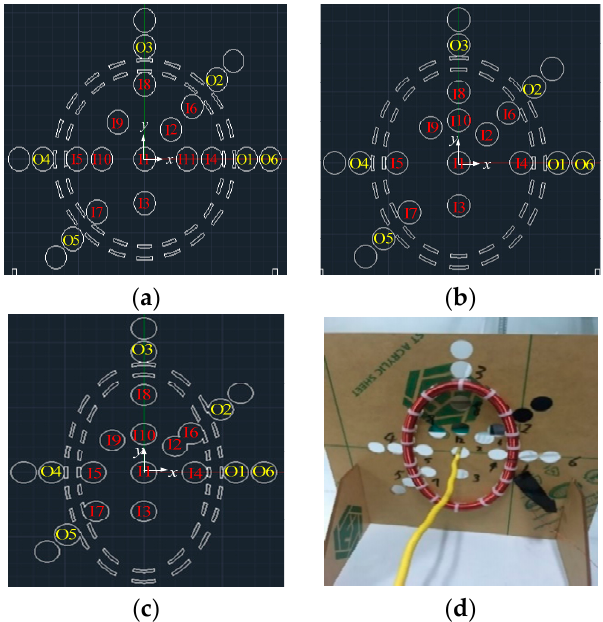
Figure 5. Fixed plates with test holes. ( a ) The fixed plate of Coil A; ( b ) the fixed plate of Coil B; ( c ) the fixed plate of Coil C; ( d ) the picture of the test plate. fixed plate of Coil C; ( d ) the picture of the test